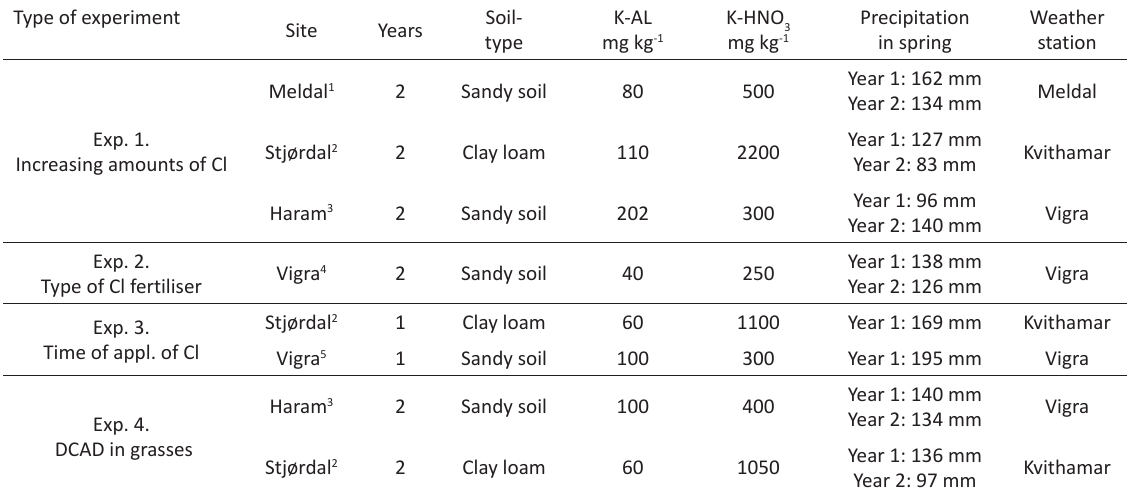
Table 1. Information on the different experiments and sites. The figures for precipitation are given for the period from spring fertilisation to the first harvest. Type of